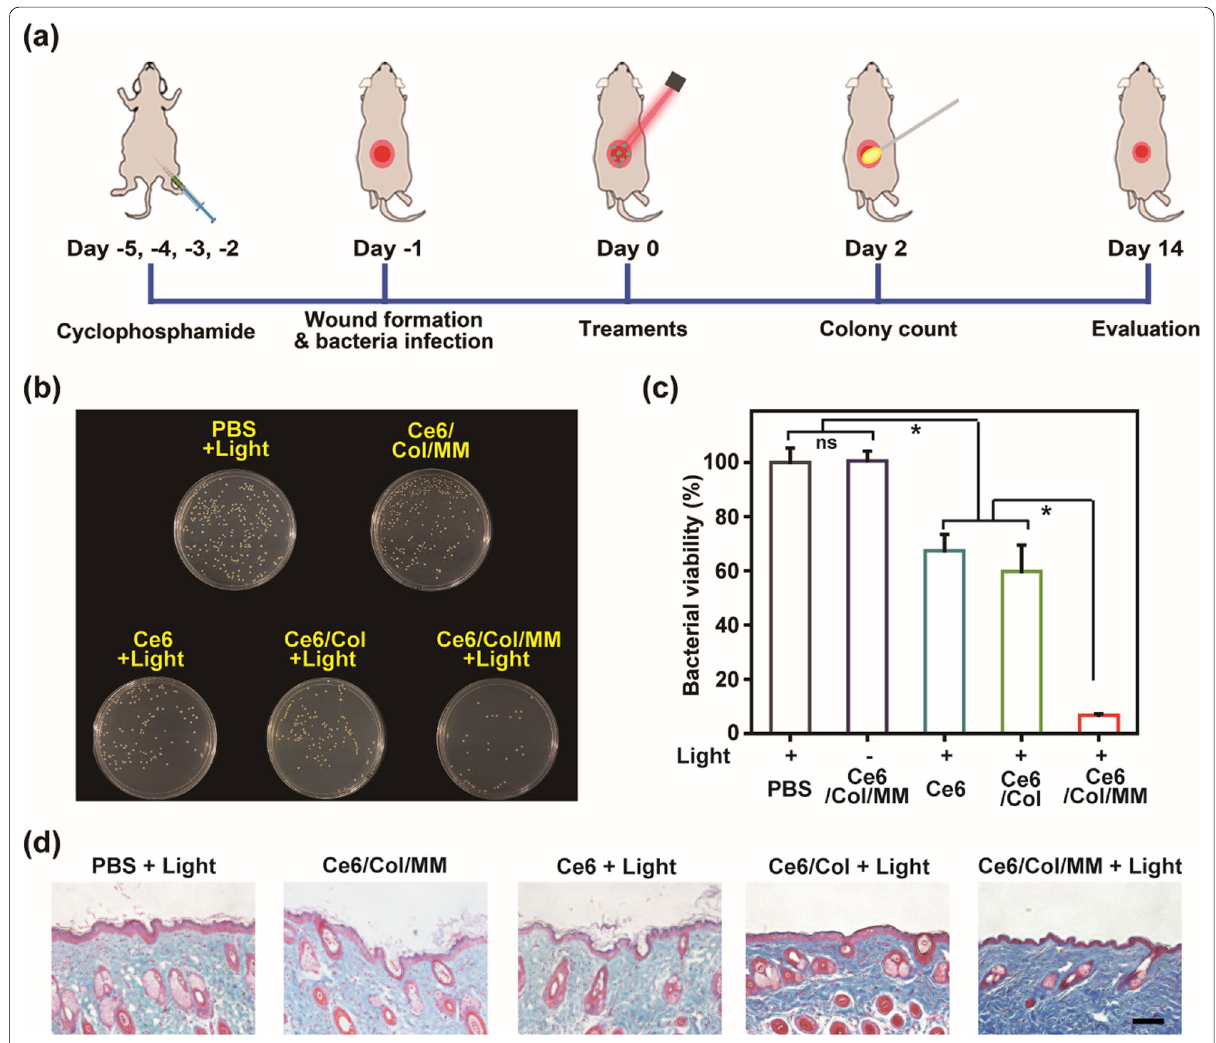
Fig. 5 In vivo antibacterial activity of Ce6/Col/MM in MRSA-infected wound model. a Diagrammatic sketch for establishment of MRSA-infected wound mouse model and treatment plan. b Images of bacteria colonies derived from the exudate of the infected region of mice subjected to various treatments as indicated. c Quantitative analysis of bacterial survival rate in each group based on ( b ). d Masson’s trichrome-stained tissue of MRSA-infected wound mouse after various treatments. Scale bar: 100 μm. Data are shown as means